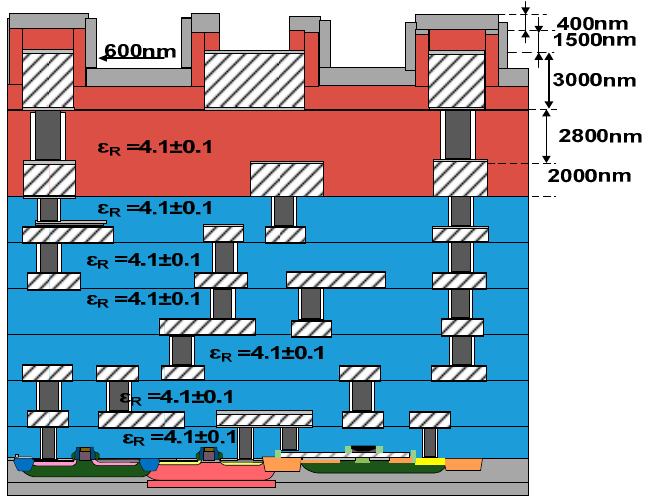
Figure 1. Back-end-of-the-line (BEOL) cross section of the 130-nm SiGe BiCMOS technology.